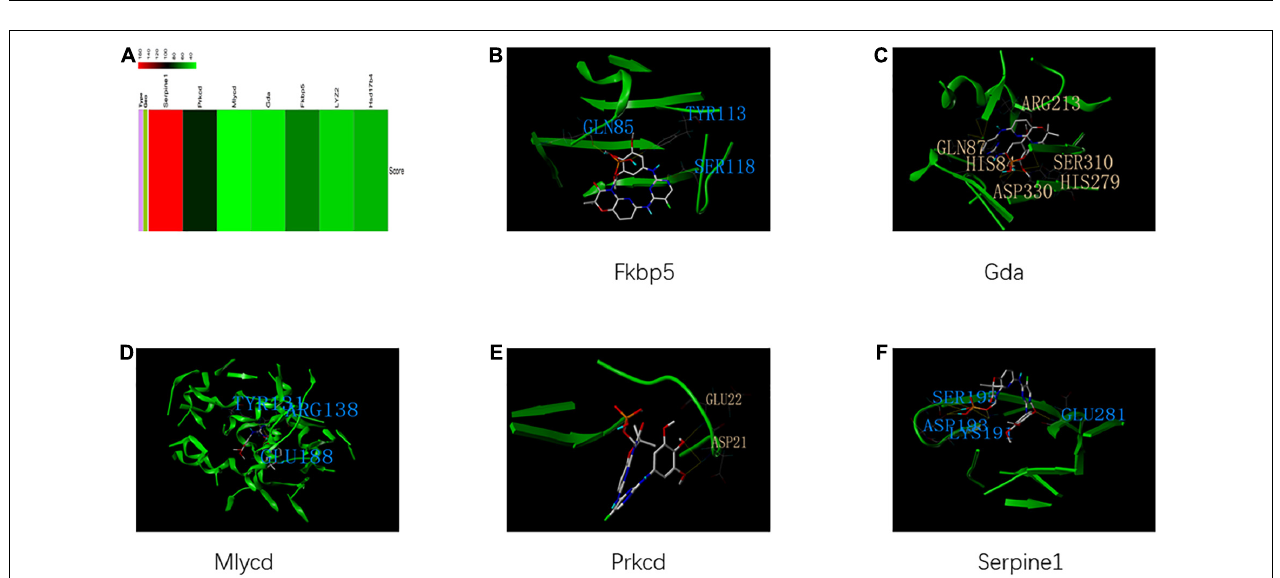
FIGURE 8 | Modules in the merged protein–protein interaction (PPI) network. (A) The composition of the modules. (B) Function enrichment results of the modules.